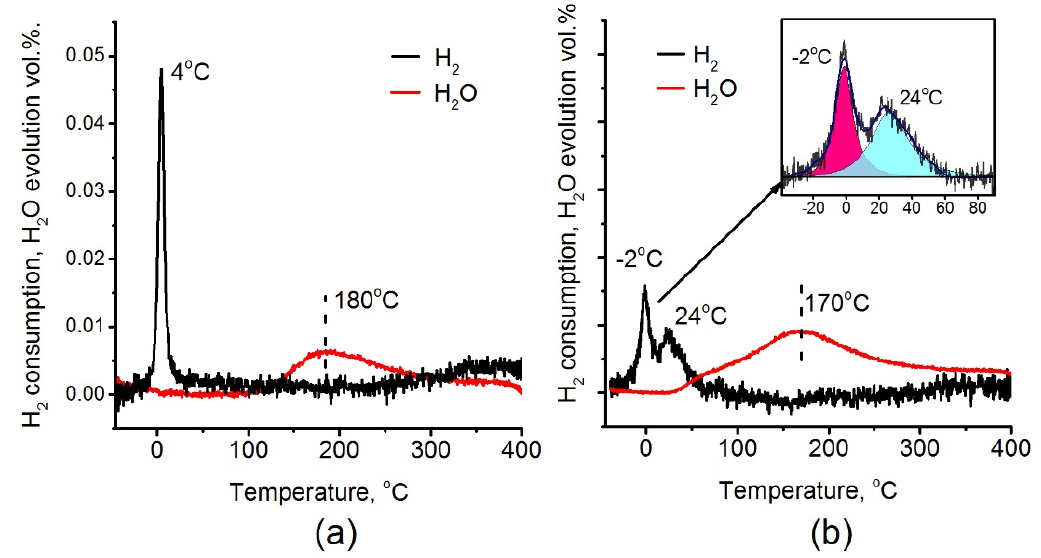
Figure 9. H 2 consumption and H 2 O evolution during temperature-programmed reduction (TPR-H 2 ) for ( a ) Pt/Ti-PLA-400 and ( b ) Pt/Ti-P-25-400 catalysts.